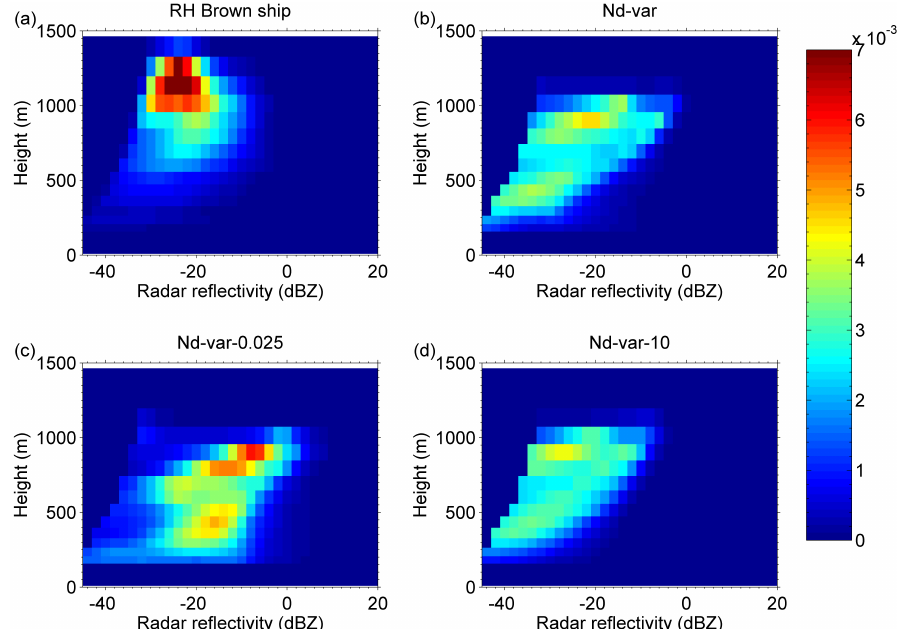
Figure 14. Two-dimensional relative frequency plot for radar reflectivity vs. height from the RV Ronald H. Brown W-band radar and for var- ious model runs. The relevant model data are available every 30min and data between the times of 06:00UTC (01:12LST) on 12 November and 00:00UTC (19:12LST) on 14 November are used, with the first 6h of model data being avoided due to spin-up. Ship radar profiles are available every 0.3s and are used for the same time period as the models. Model data are used for the 1 ◦ × 1 ◦ region around the location of the ship. The colours indicate the normalized frequency of occurrence for each bin and the ship and model bin sizes are the same. Note that many of the data points lie beyond the minimum value on the x axis (i.e. very low radar reflectivity) and are not visible, but they are included for the normalization. The ship radar has a minimum detectable reflectivity that increases with height; model data below this height-dependent threshold were set to −